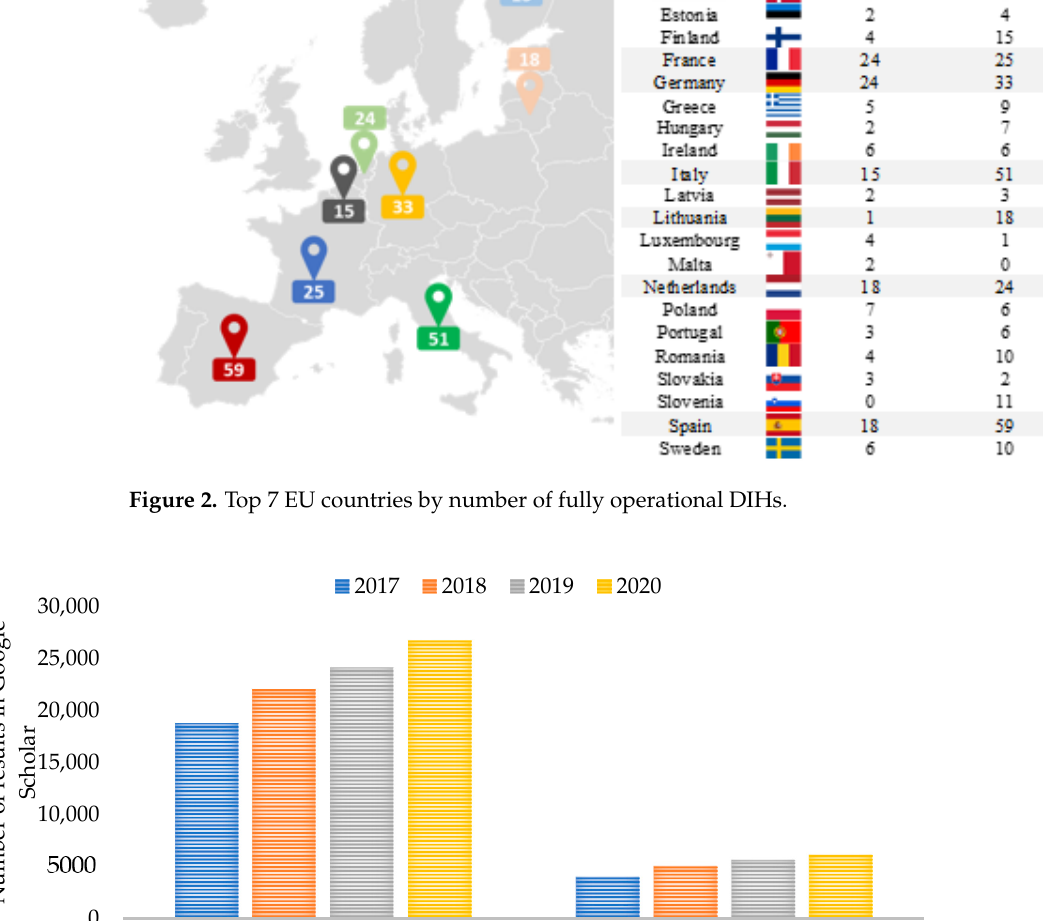
Figure 4. Interest over the last four years in DIH, generated via Google Trends.